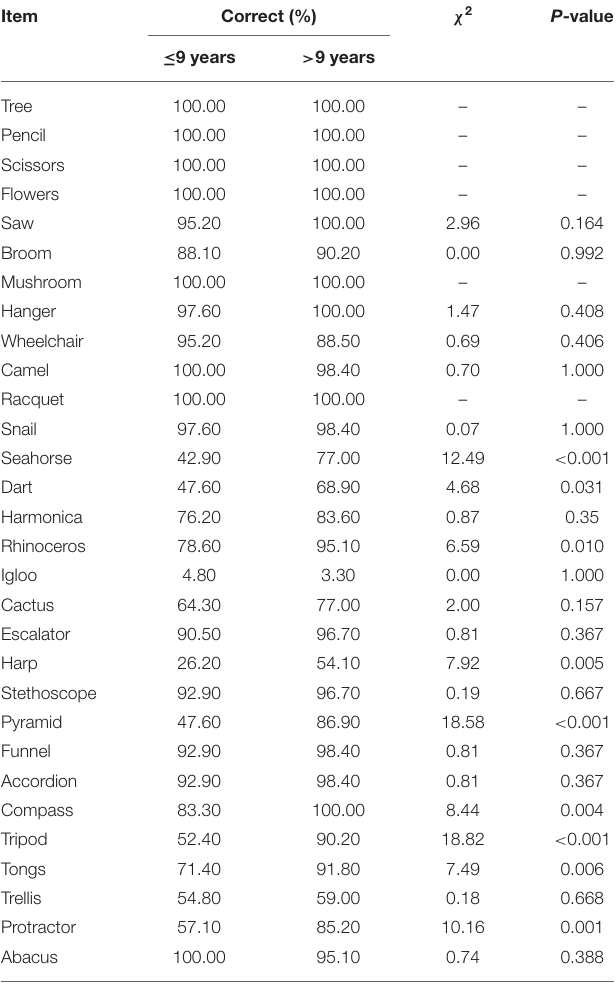
TABLE 4 | Percentage of correct BNT-C between two different education